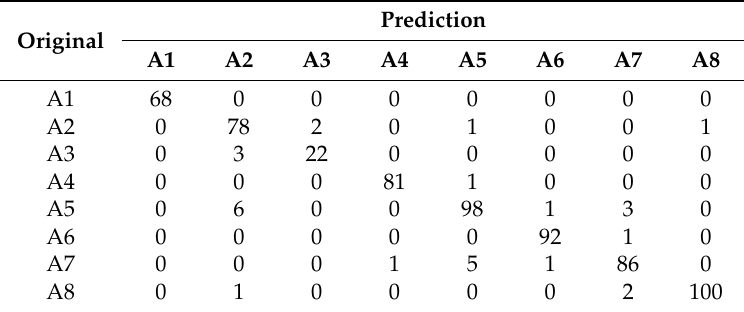
Table 5. Confusion matrix generated by the multichannel model based on a segment length of 512 (A1: climbing down; A2: climbing up; A3: jumping; A4: lying; A5: running; A6: sitting; A7: standing; and A8: walking). Original